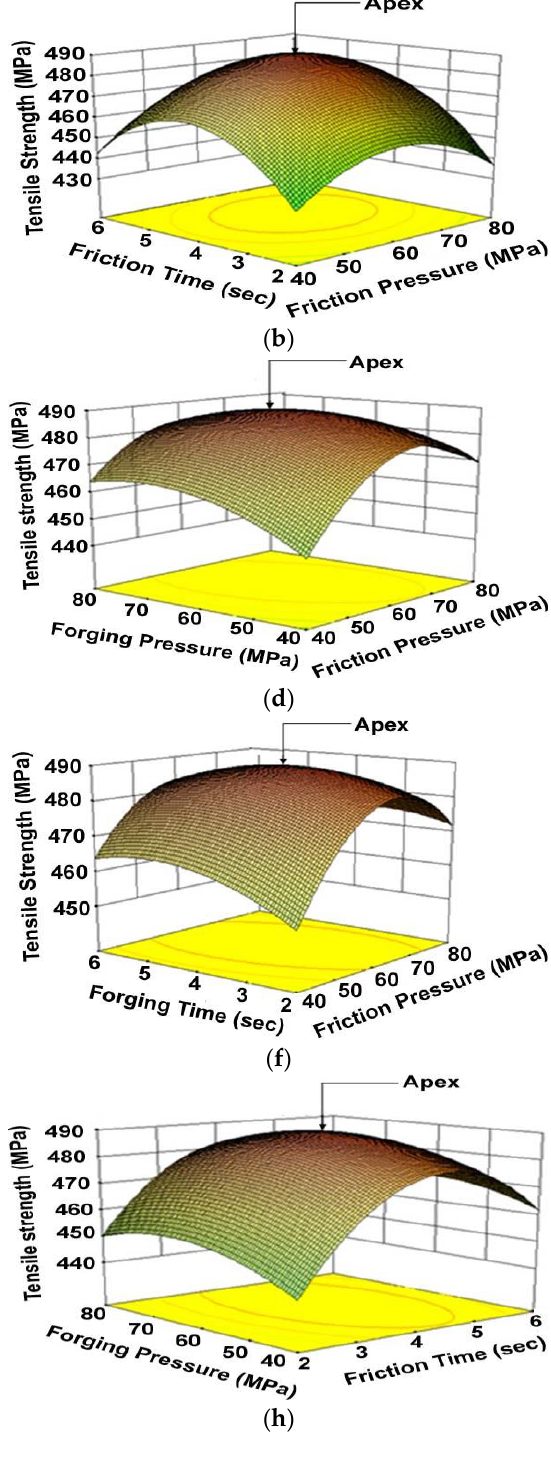
Figure 3. Response graphs and contour plots for the effect of parameters on tensile strength ( a-h ).